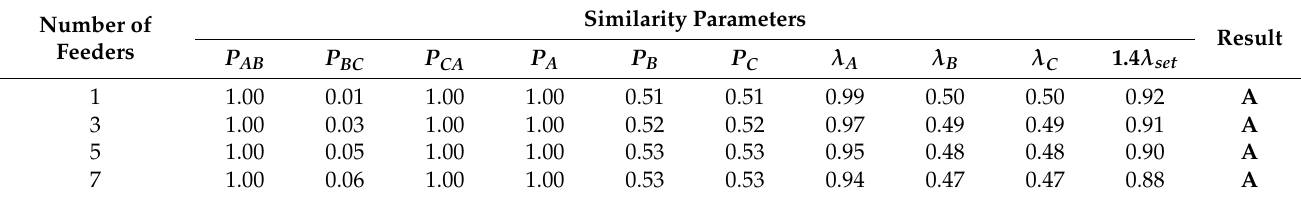
Table 8. Similarity parameters and faulty phase selection results under the influence of the system topology. Number of